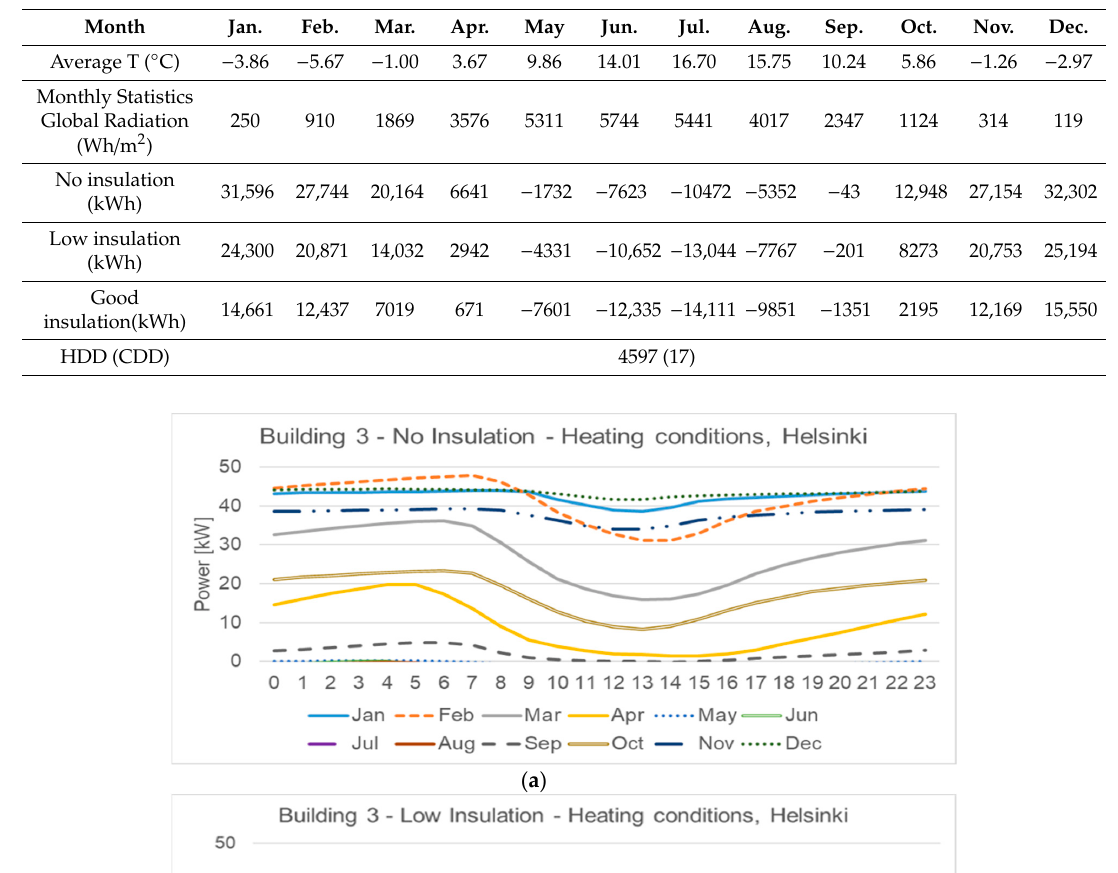
Table 5. Average monthly climatic data and energy demand of Helsinki.